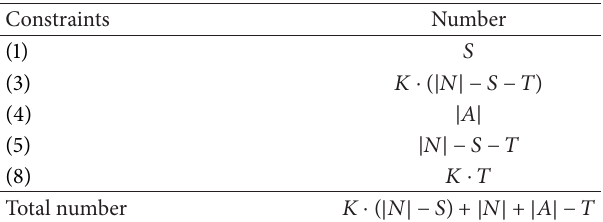
Table 3: The amount of constraints in each constraint condition. Constraints